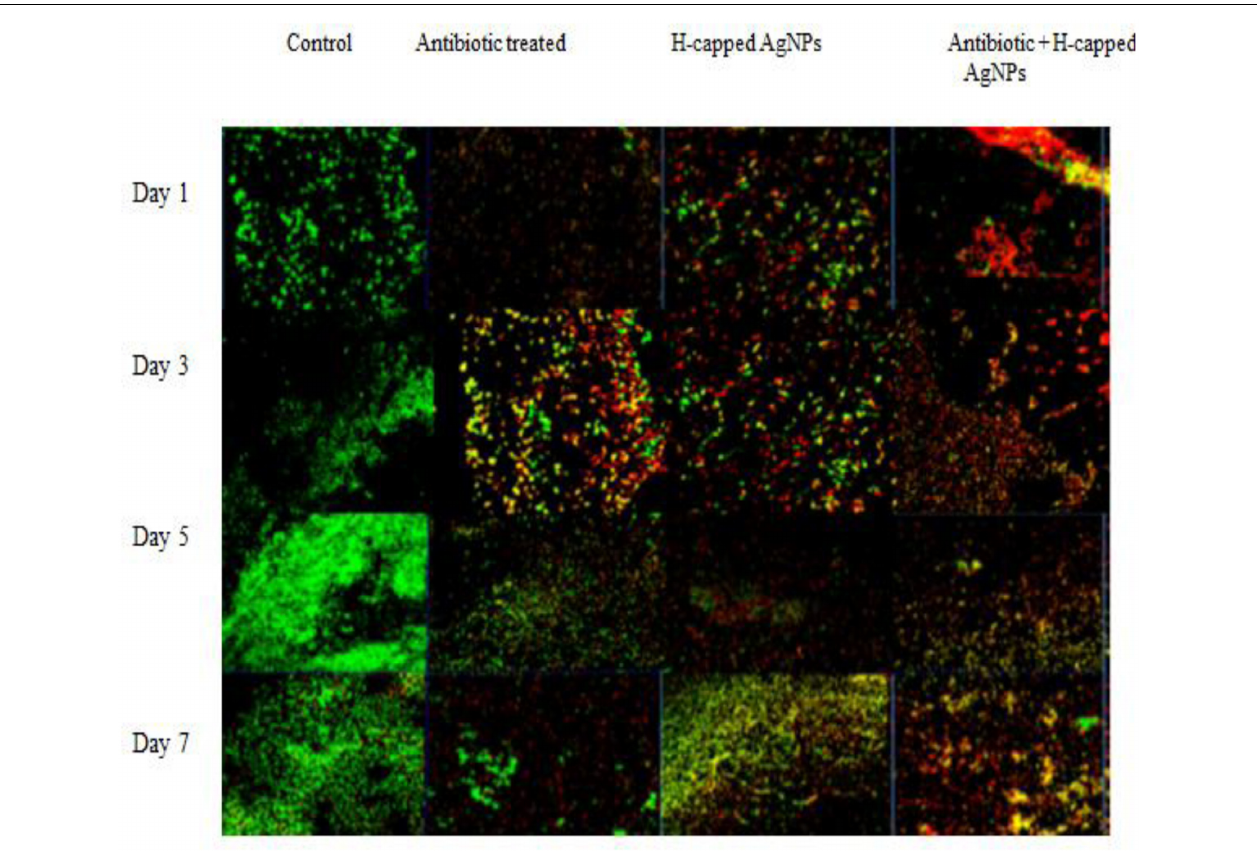
FIGURE 9 | K. pneumoniae bioflim stained with LIVE/DEAD Baclight kit and treated with H-AgNPs and gentamicin, alone or in combination. The bioflim observed under CLSM (40x) shows distribution of live/dead bioflim cells on different days of incubation.